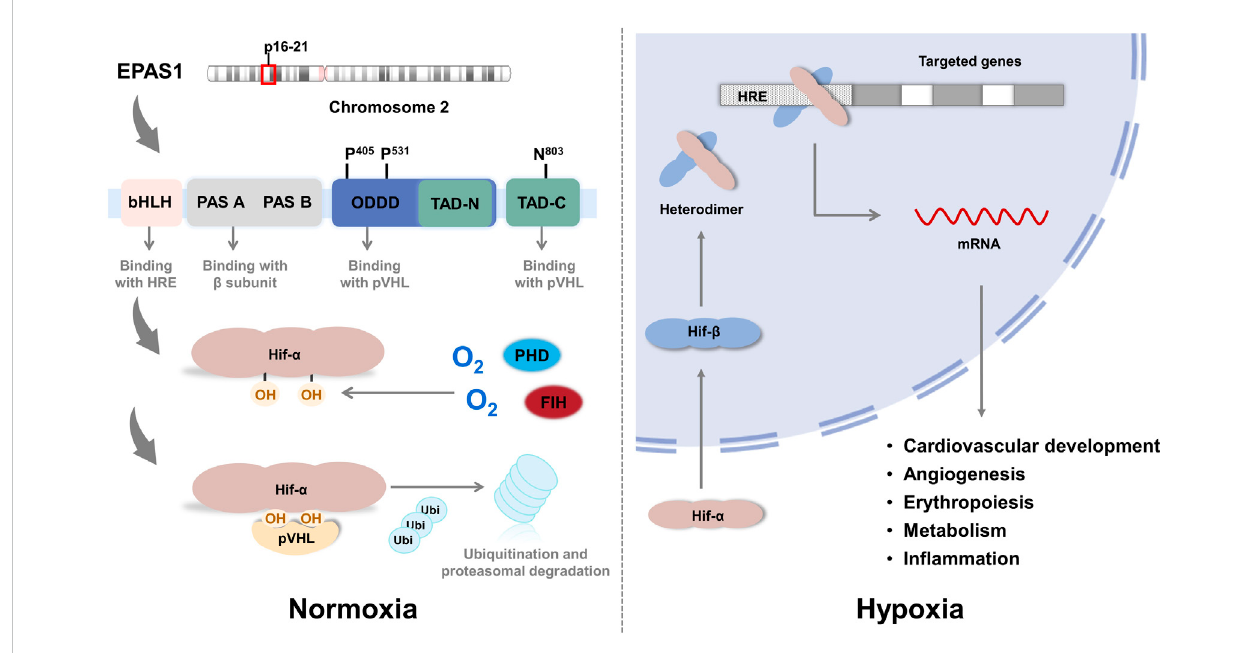
FIGURE 2 The structure of